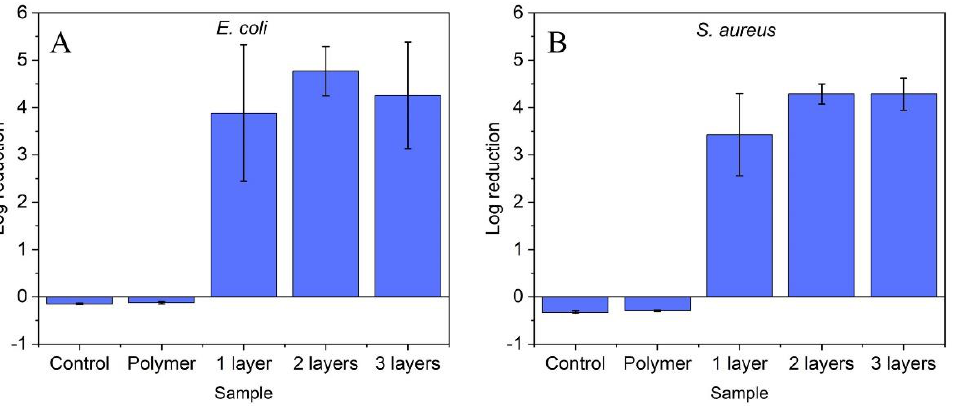
Figure 4. Log reduction of ( A ) E. coli and ( B ) S. aureus on ZnO coated surfaces after one, two and three deposition steps. Non-coated polymer surfaces of the same size were used as control. Standard deviation represents the average of three separate